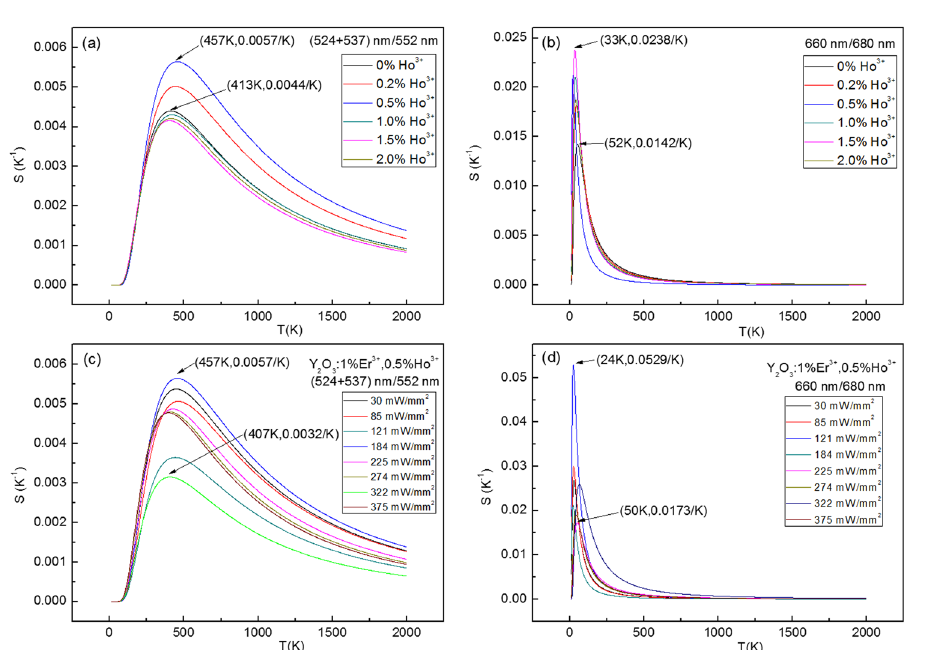
Figure 15. Doped concentration dependent sensitivity of Y 2 O 3 :1%Er 3 + , y%Ho 3 + (x = 0, 0.2, 0.5, 1.0, 1.5, 2.0), and excitation powers dependent sensitivity of Y 2 O 3 :1%Er 3 + , 0.5%Ho 3 +